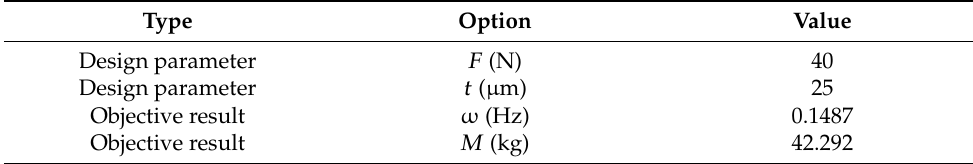
Table 7. Multiobjective optimization result for the membrane